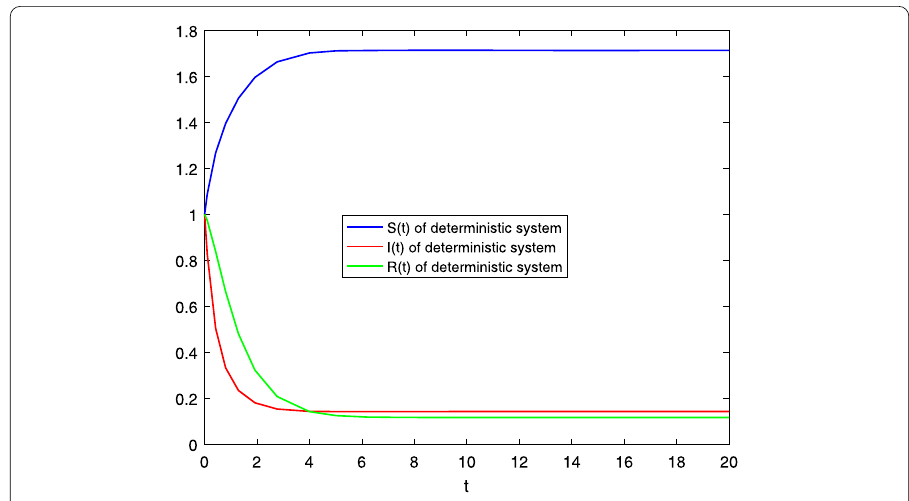
Figure 3 Time series for S ( t ), I ( t ), R ( t ) of the deterministic SIR system with β = 2, (cid:2) = 2, α = 0.2, a = 1, μ = 1, r